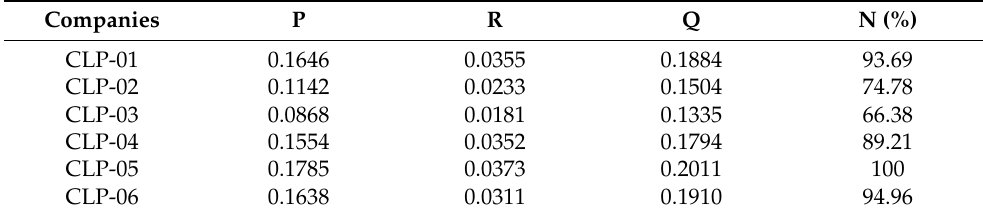
Table 14. The utility degree of the